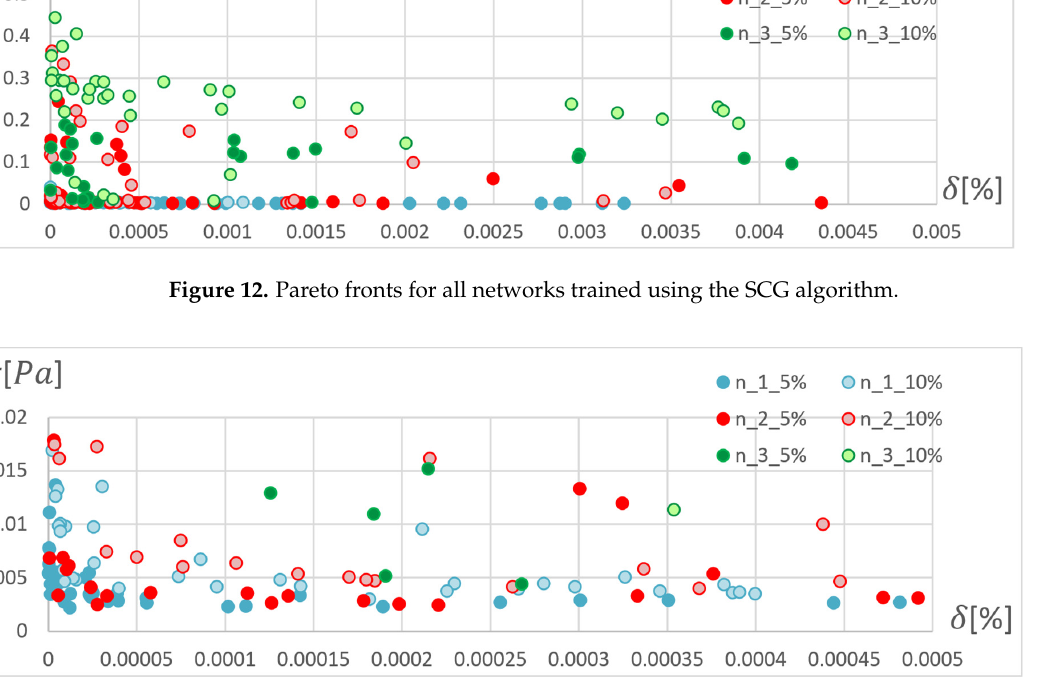
Figure 13. Pareto fronts representing the neural networks with the highest accuracy, trained using the SCG algorithm.